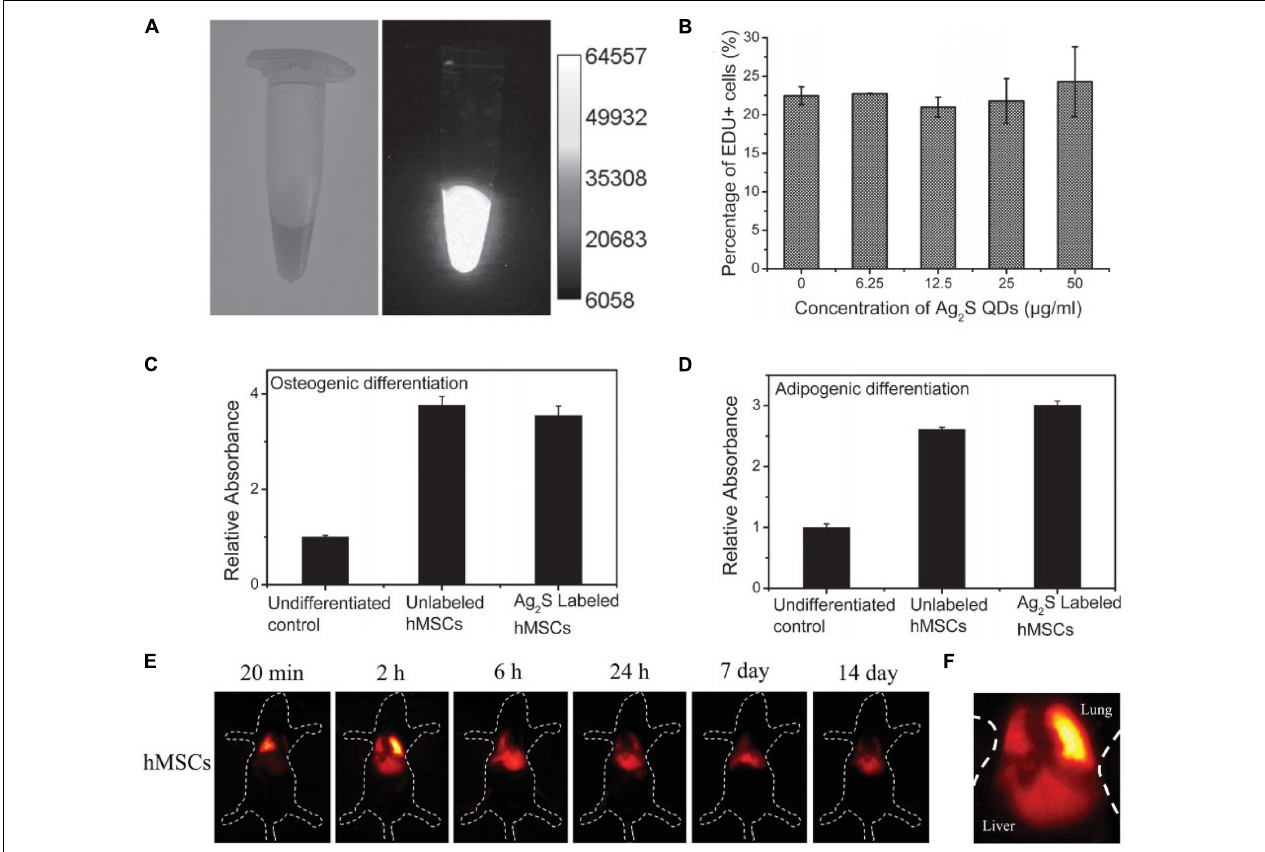
FIGURE 4 | (A) A photoluminescence image (PA) of the Ag 2 S QD-labeled human MSC solution at a density of 4 × 10 6 cell ml − 1 . (B) Cell proliferation. Quantification of (C) osteogenic and (D) adipogenic differentiation by measuring the absorbance of Oil-Red O and alizarin red extracted from cell lysates at 404 nm, respectively. (E) The time course of the in vivo near-infrared (NIR) PL images of a healthy mouse after transplantation of Ag 2 S QD-labeled human MSCs. (F) Higher magnification NIR PL image of mice transplanted with human MSCs only after 2 h (adapted from Chen G. et al.,